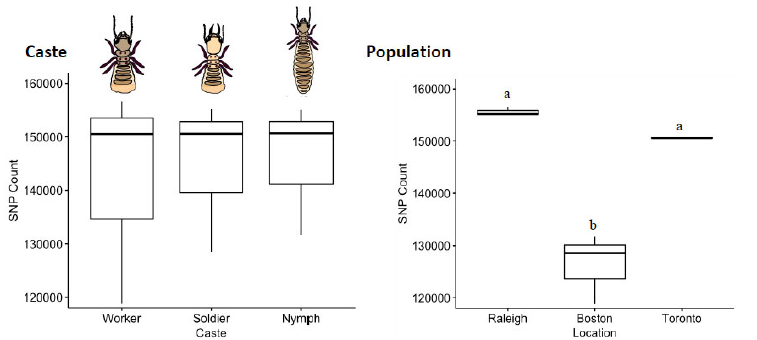
Figure 4. Counts of SNVs by caste and population. Termite castes are relatively uniform in SNV diversity. A pair-wise post-hoc analysis indicated that workers, soldiers and nymphs all harbour nearly identical levels of diversity in their transcribed sequences (Pairwise post-hoc Dunn Test, p > 0.4 in all cases). Among populations, however, termites collected from Raleigh were more variable than were those collected from Boston (Dunn tests; p = 0.0109), with the Toronto population being intermediate (Dunn test; p > 0.08 in both cases). Error bars are 95% CI. Different letters above boxes indicate a significant difference. Note that for the Toronto termite population, the three caste libraries used had a very similar SNV counts, and the estimate of variance is